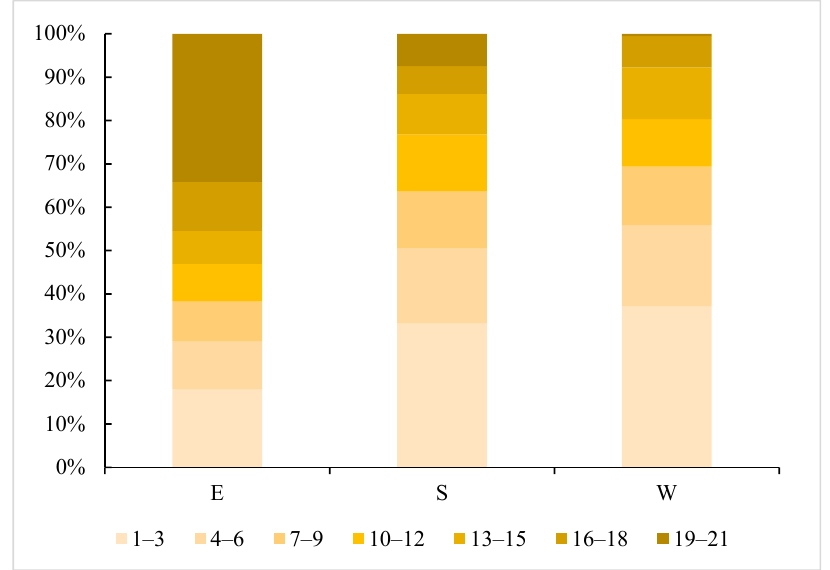
Figure 10. The proportion of the seven levels’ frequencies in the three wetland reserves.